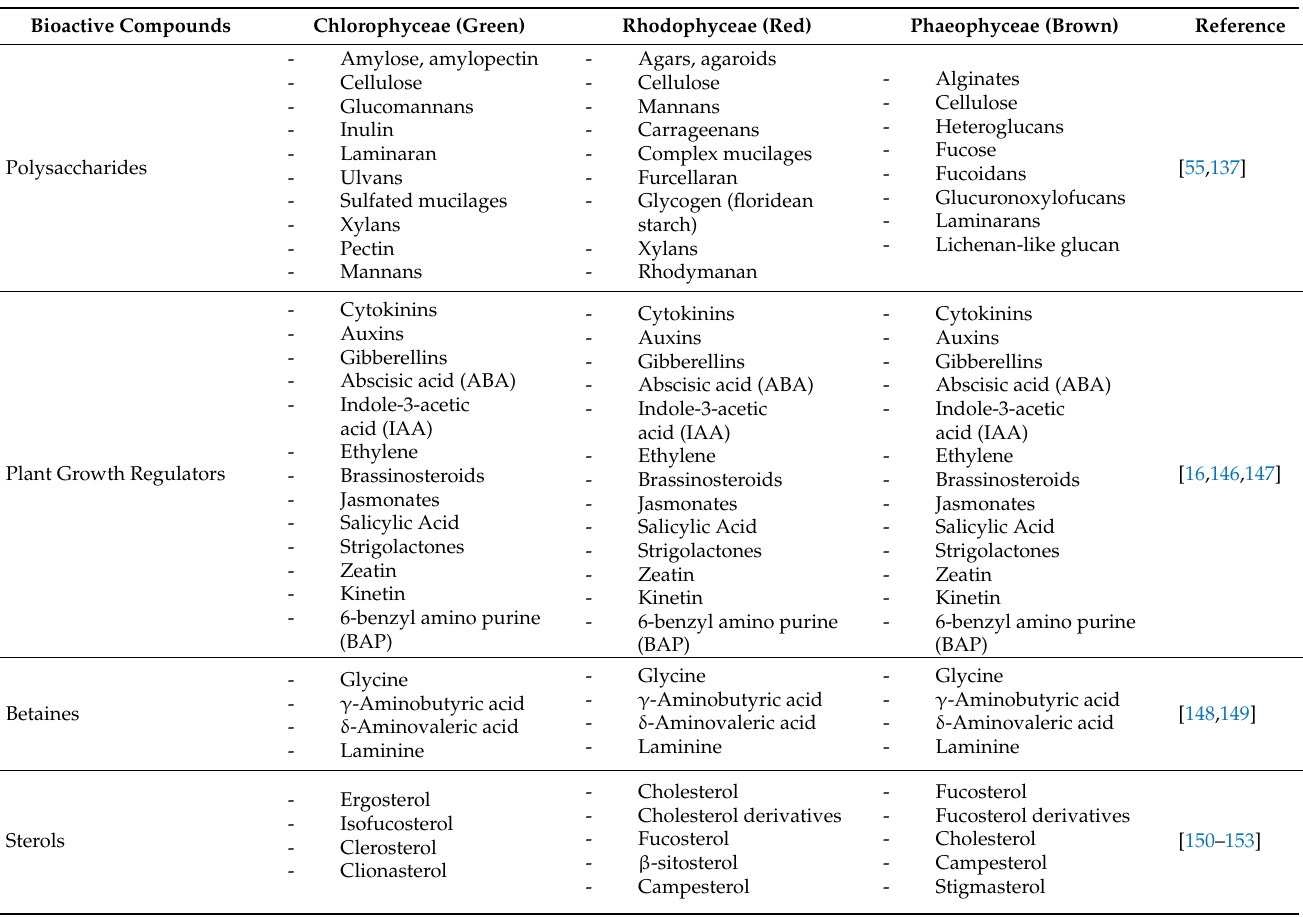
Figure 2. The estimated composition of seaweed extracts belonging to the three mega classes of seaweeds (red, green and brown). Table 3. Major bioactive components of seaweed extracts.